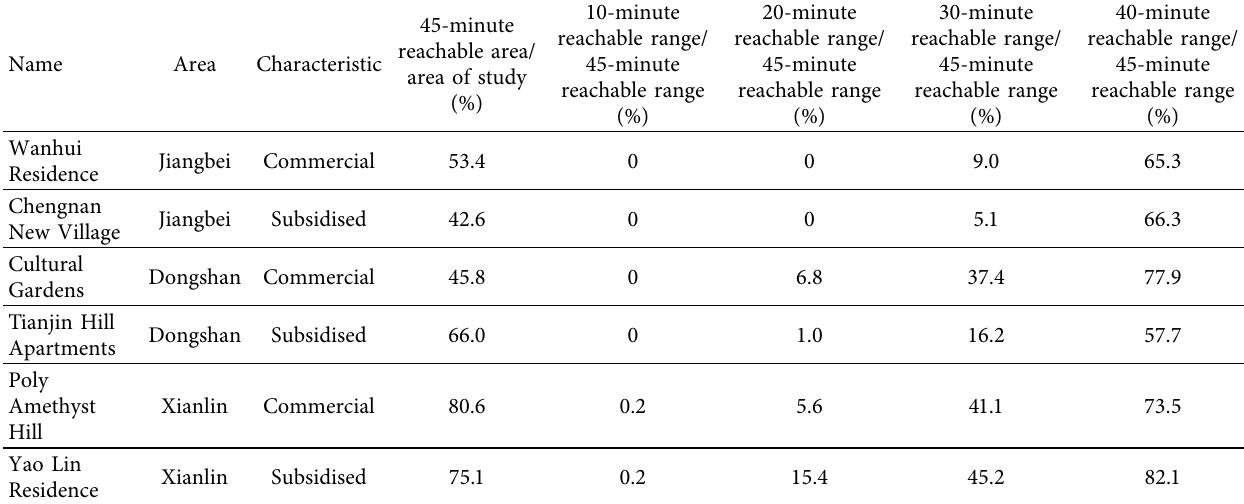
Table 2: Proportion of different reachable ranges from each residential area to the main city in the morning peak on January 23 (normal weather).